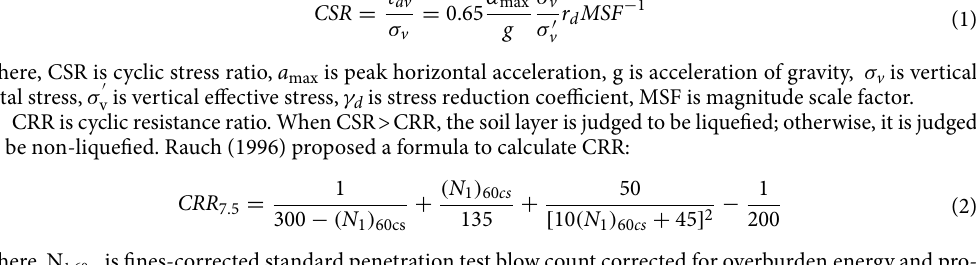
where, N 1,60cs is fines-corrected standard penetration test blow count corrected for overburden,energy and pro- cedural differences. Seed-Idriss method’s point at liquefaction and non-liquefaction site are presented in Fig. 11.This method can gives an accurate prediction to the Shallow sand liquefaction (Fig. 11a).For deep liquefaction under 17 m, this method gives a error prediction (Fig. 11b).